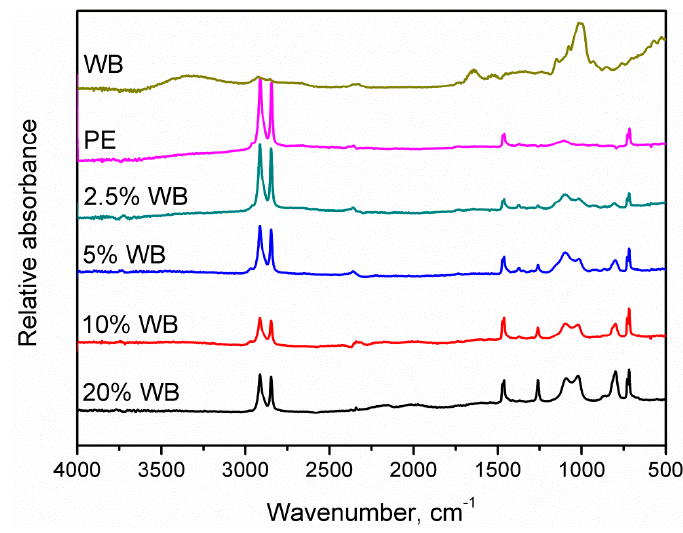
Figure 4 . Fourier transform infra-red (FTIR) spectra of prepared composites. Figure 4. Fourier transform infra-red (FTIR) spectra of prepared